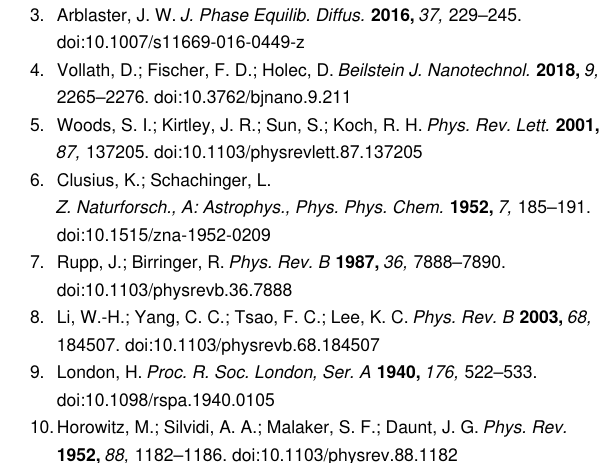
Figure 7: Particle size distribution of lead particles calculated by evalu- ation of the magnetic susceptibility χ ’ as function of the temperature as shown in Figure 6. For this normal distribution, the parameters = 4.2 nm and σ = 0.5 nm were